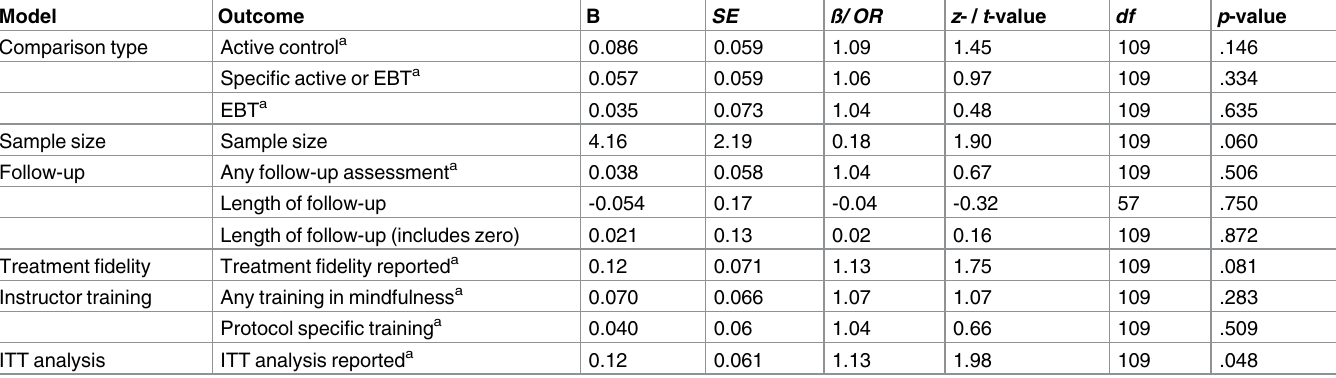
Table 3. Study quality predicted by year of publication (European and North American sample only).